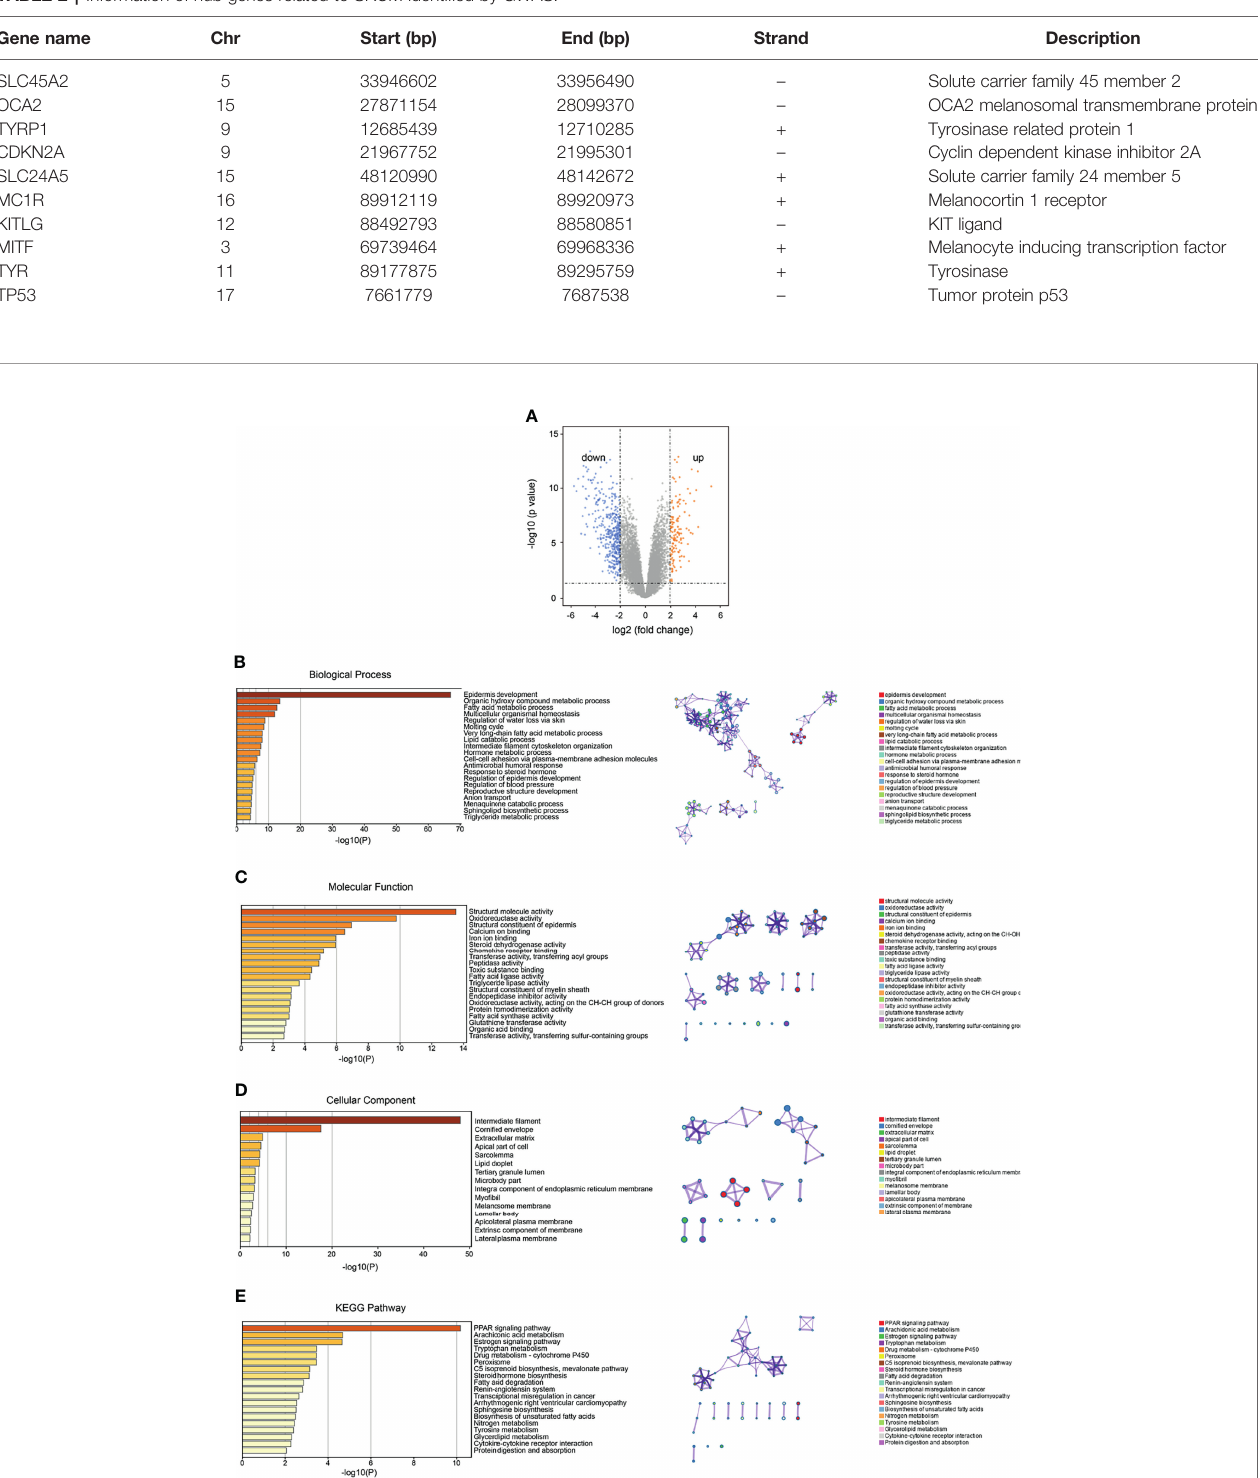
TABLE 2 | Information of hub genes related to SKCM identi fi ed by GWAS.